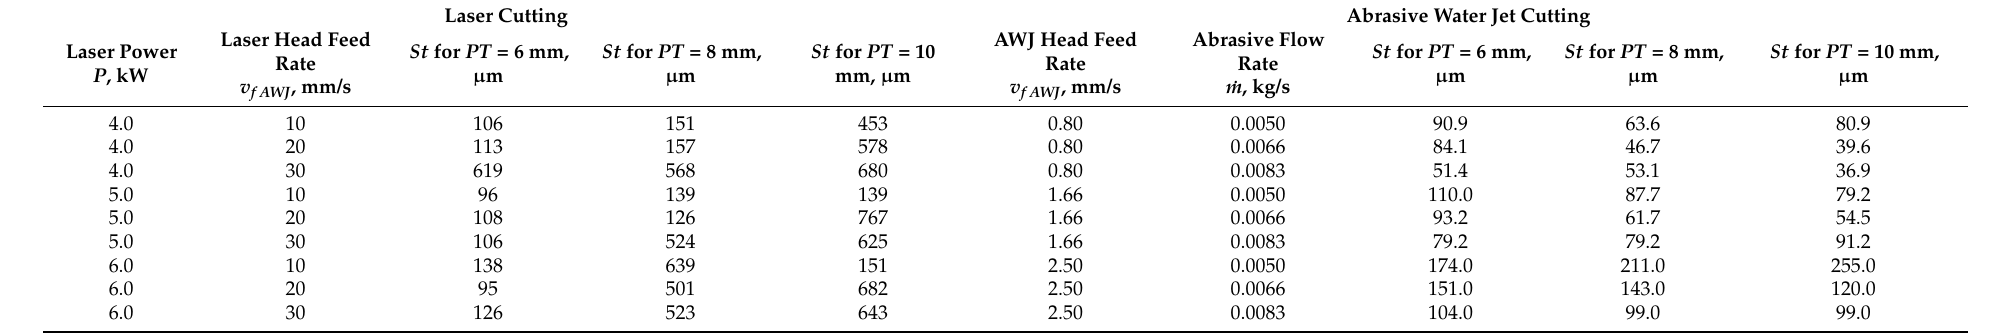
Table 3. Values of the St parameter of the surface after cutting for plate with thickness PT = 6, 8 and 10 mm and for variable power P and cutting head feed rate v f LASER in laser